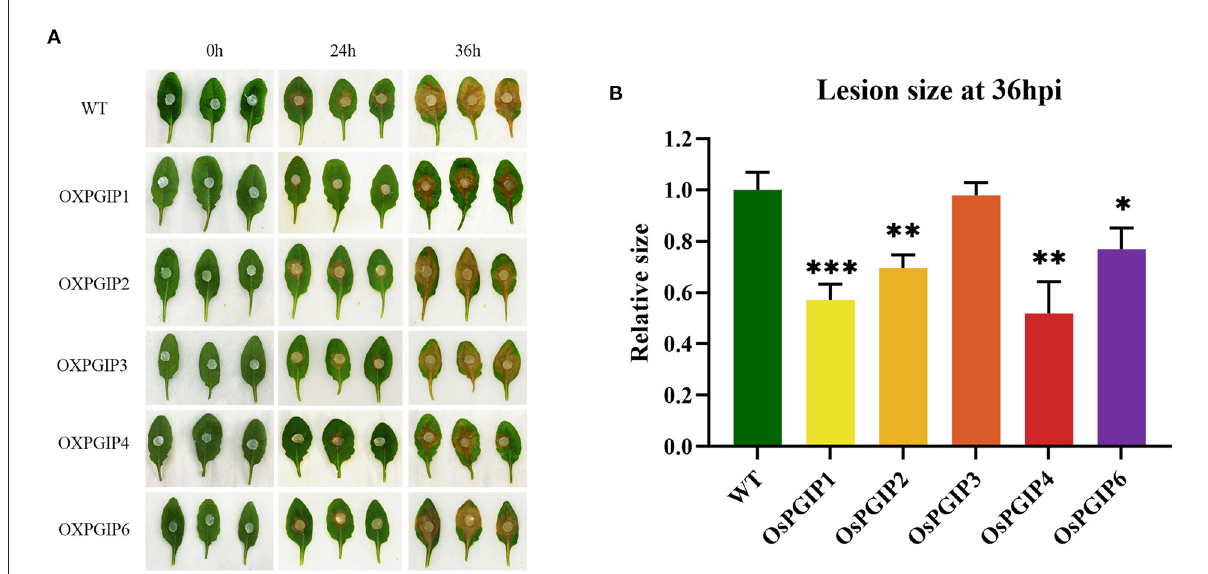
FIGURE3 S. sclerotiorum resistance assay in OsPGIPx transgenic Arabidopsis. (A) Phenotypes of pathogenicity assays on detached leaves from different transgenic plants at 0h, 24h and 36h after inoculation with S. sclerotiorum . (B) Statistical analysis of relative lesion sizes on the inoculated leaves at 36 hpi. Significant differences were showed by: *** P < 0.001, ** P < 0.01, * P < 0.05. Error bars indicate SE based on three independent biological replicates.